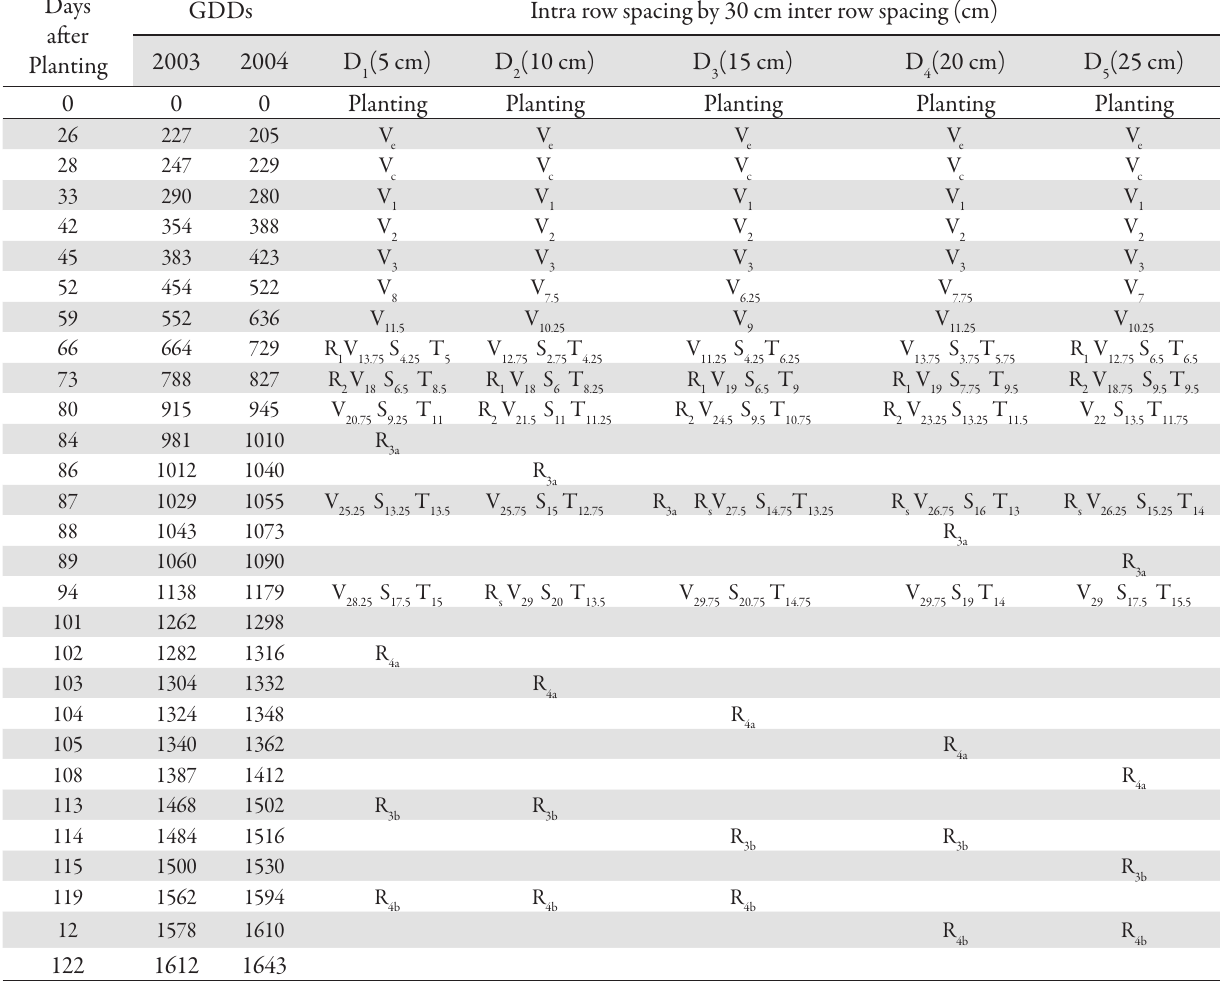
Tab. 3. Growth stages of Matricaria chamomilla L. under plant densities Days after Planting